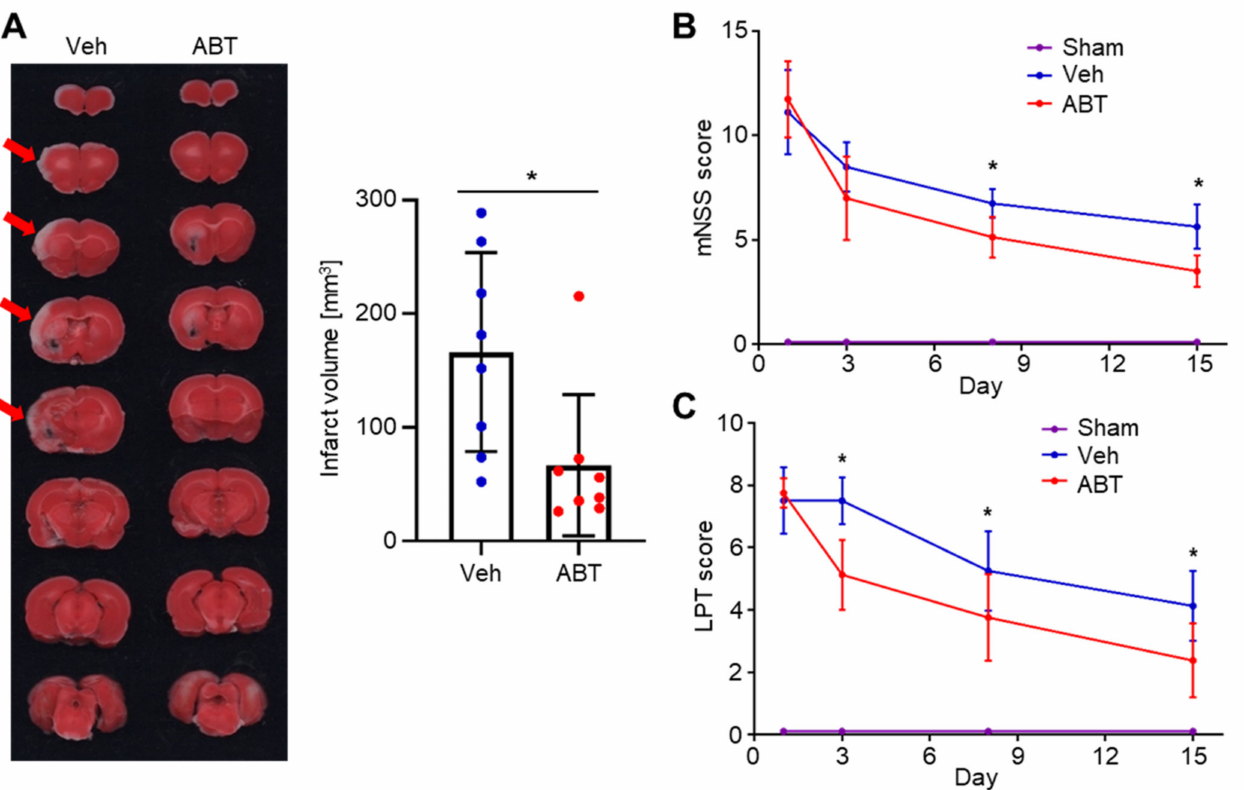
Figure 4. Therapeutic effect of ABT263 in MCAO ischemia-reperfusion rat model. MCAO rats were treated with intravenous injections of either vehicle (Veh) or ABT263 (ABT). The sham group did not receive MCAO. ( A ) 2,3,5-triphenyltetrazolium chloride (TTC) staining of serial sections of the brain and quantification of the cerebral infarct volume on day 4. The ABT263 treatment group had significantly smaller infarct volume compared to the Veh group. Arrows indicate cerebral infarct. n = 8 per group. * p < 0.05. Data are presented as mean ± SD. Mann–Whitney test was used for statistical analysis. Brain functional recoveries of MCAO rats evaluated by ( B ) the limb placing test (LPT) and ( C ) modified neurological severity score (mNSS). The mNSS tests and the limb-placing tests showed that ABT263 treatment significantly improved neurological functions after MCAO. n = 6 per group. Data are presented as mean ± SD. * p < 0.05 compared to Veh or Sham. Two-way repeated measures ANOVA was used for statistical